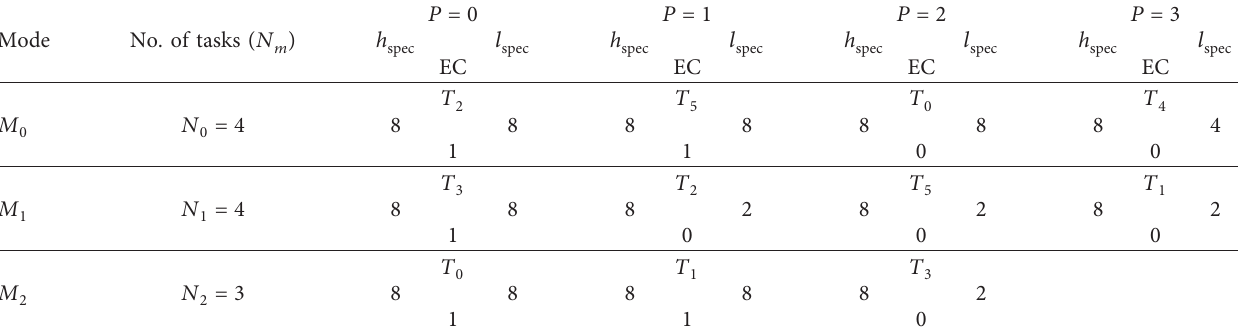
Table 1: An example of Mode-LUT for